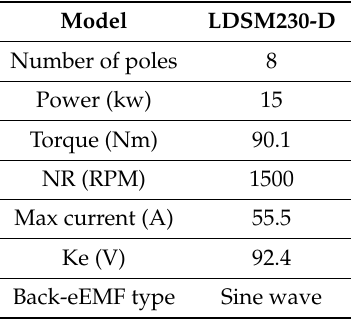
Table 1. PMSM Table 1. PMSM specifications.